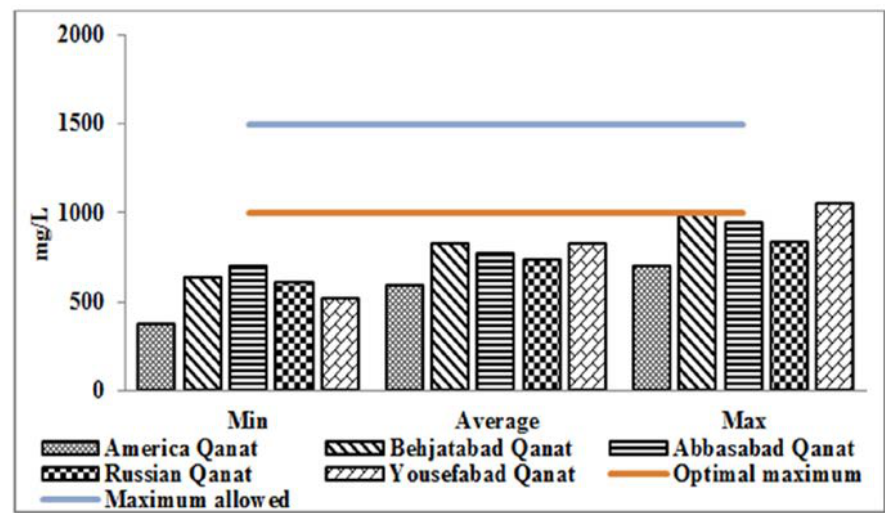
Fig. 4: TDS level and its comparison with the WHO and the National Standard of Iran